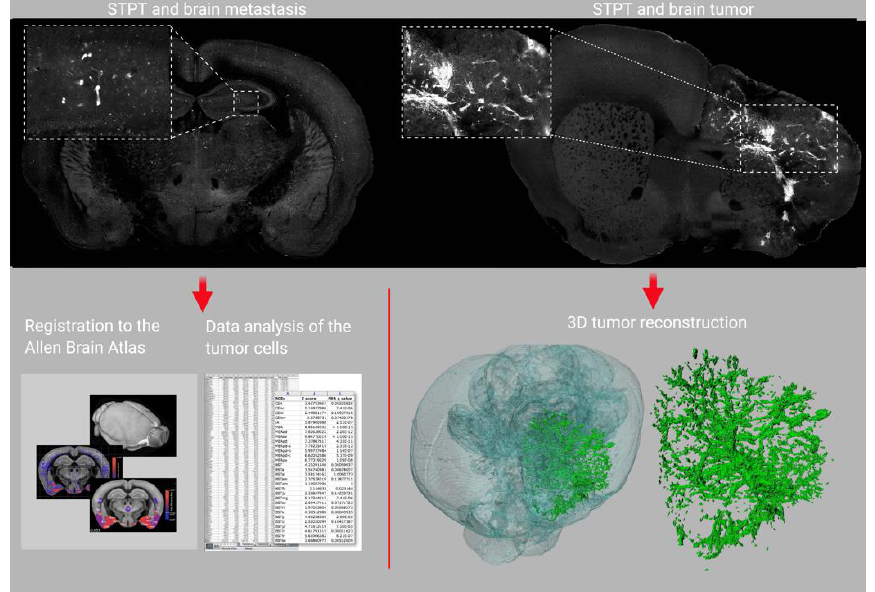
Figure 3. Fluorescent labeled tumor cells can be detected using serial two-photon tomography (STPT) (top panel), registered to a reference brain atlas (bottom left), and reconstructed in 3D (bottom right). Example STPT images are provided for preclinical brain metastasis (top left) and brain tumor (top right) models. The figure was created in BioRender.com (accessed on 12 March 2021) using our own preliminary data and exported under a paid subscription